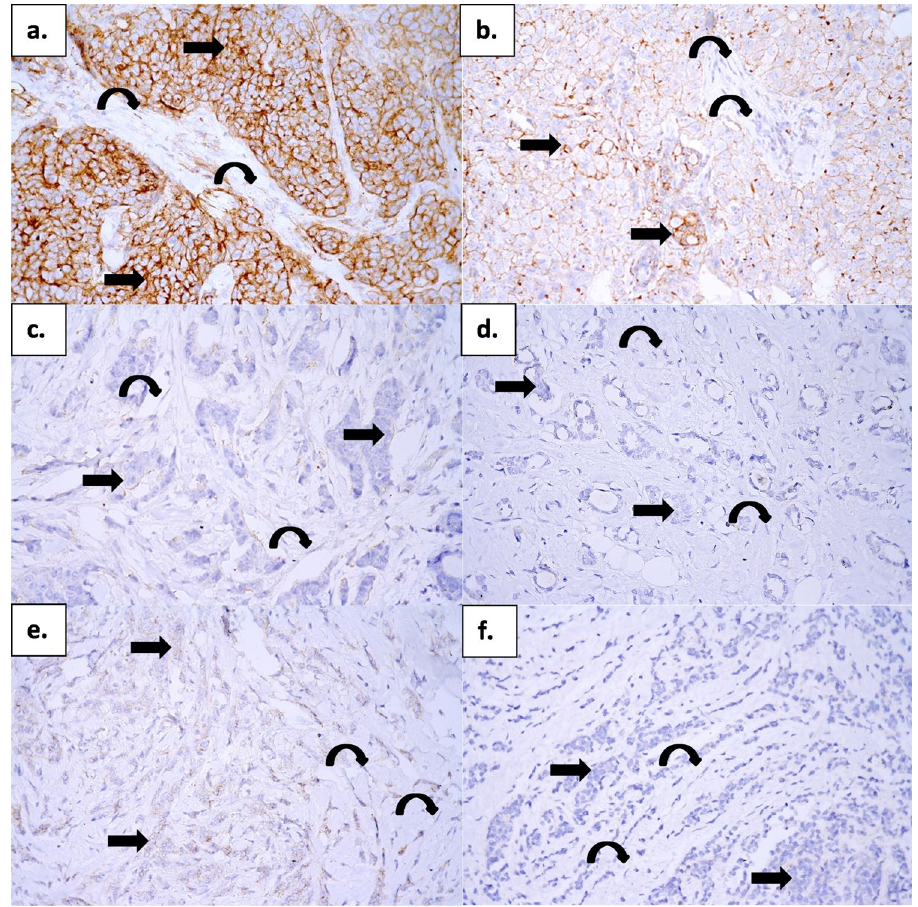
Figure 1. PD-L1 expression in primary breast tumours. Immunohistochemical reaction with an anti-PD-L1 monoclonal antibody. Original magnification ×400 visualisation with 3,3 ′ -diaminobenzidine (brown colour). ( a ) (IDC grade 3) strong positivity in tumour cells (arrow) and weak positivity in stromal cells (curved arrow), ( b ) (IDC grade 3) weak to moderate positivity in tumour cells (arrow) and negativity in stromal cells (curved arrow), ( c ) (IDC grade 3) focal weak positivity in tumour cells (arrow) and negativity in stromal cells (curved arrow), ( d ) (IDC grade 1) negativity in tumour cells (arrow) and stromal cells (curved arrow), ( e ) (ILC) weak positivity in tumour cells (arrow) and negativity in stromal cells (curved arrow), ( f ) (ILC) negativity in tumour cells (arrow) and stromal cells (curved arrow). IDC, invasive ductal carcinoma; ILC, invasive lobular